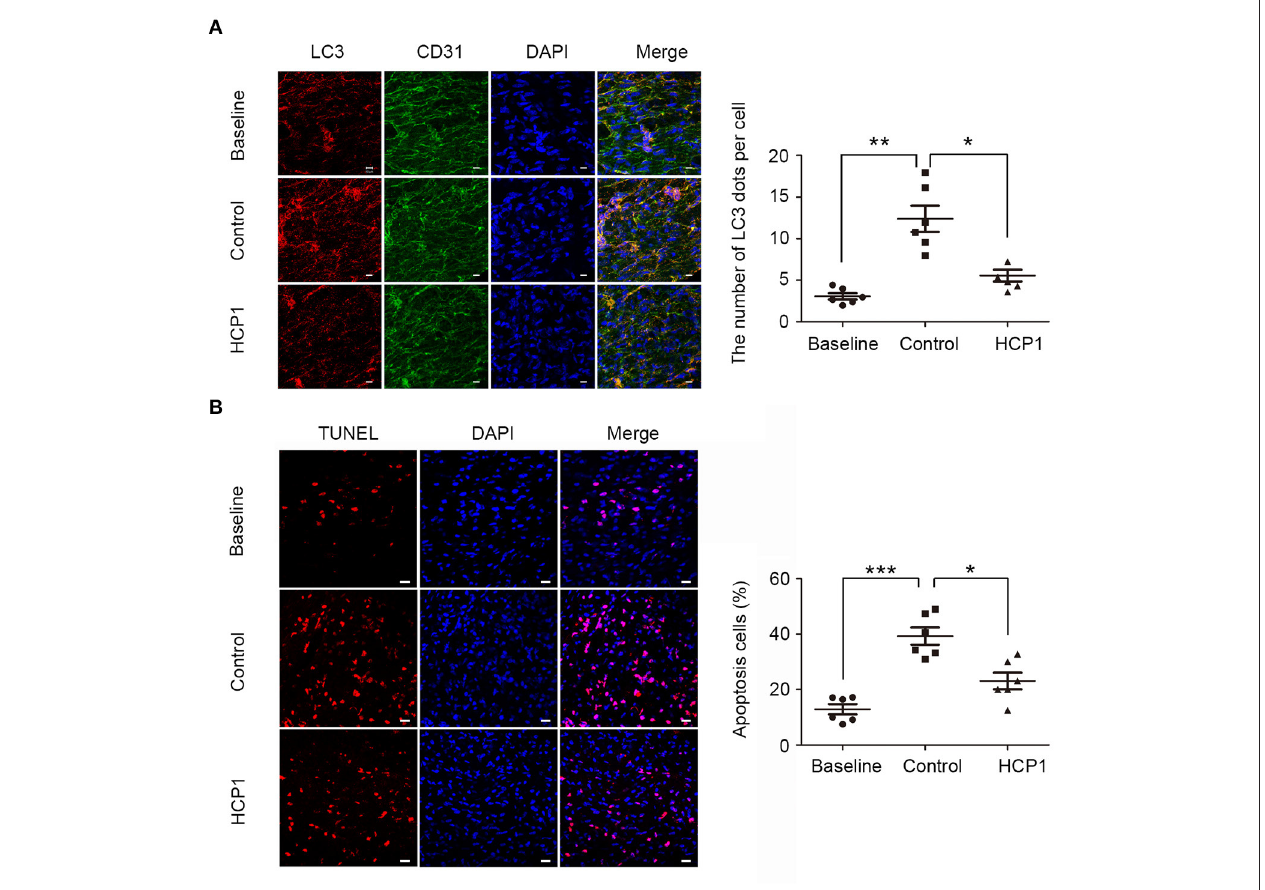
FIGURE 6 | HCP1 inhibited endothelium autophagy and apoptosis in apoE − / − mice. (A) En face staining of LC3 patches in the thoracic aorta endothelium of apoE − / − mice. Endothelial cells were marked with CD31. Nuclei were stained with DAPI. Bar charts show the quantification of average endogenous LC3 dots per cell. Scale bar, 10 µ m. (B) En face TUNEL staining of apoptotic cells in the thoracic aorta endothelium of apoE − / − mice. Nuclei were stained with DAPI. Bar charts show the quantification of the percentage of apoptotic cells. Scale bar, 20 µ m. Data are mean ± SEM; * p < 0.05, ** p < 0.01, *** p < 0.001; n = 6. Statistical analyses were performed using one-way